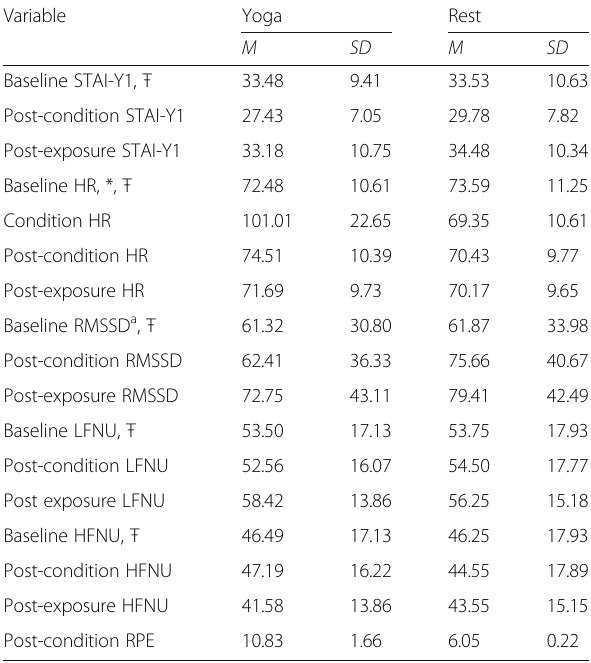
Table 2 Means and standard deviations of examined variables